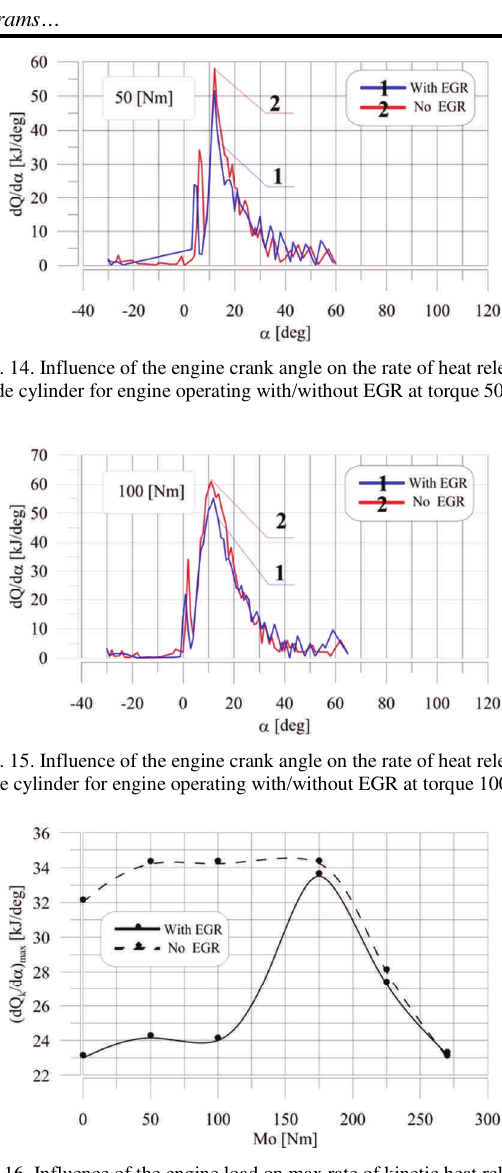
Fig. 16. Influence of the engine load on max rate of kinetic heat release (dQ k /d a ) max for engine operating with/without EGR